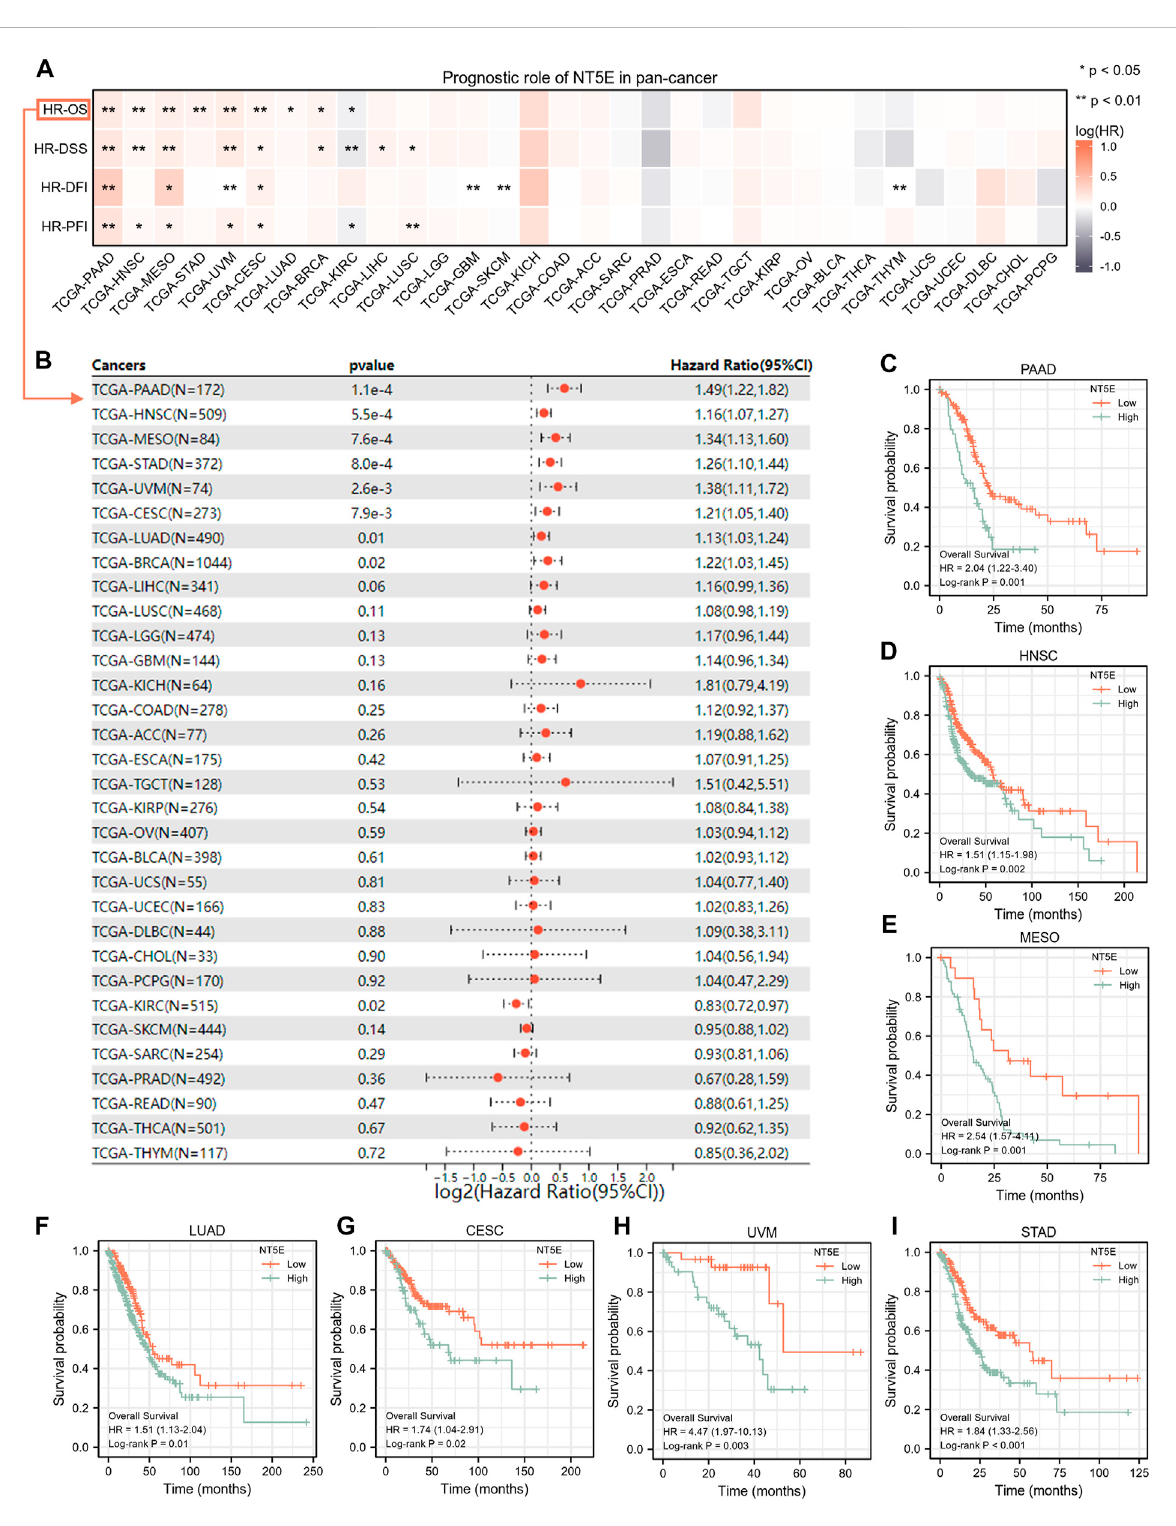
FIGURE 2 (A) the relationship between expression level of NT5E and overall survival (OS), disease-speci fi c survival (DSS), disease-free interval (DFI) and progression-freeinterval(PFI)throughtheunivariateCoxregressionandKaplan-Meiermodels.RedrepresentsthatNT5Eisariskfactor,andgrayindicatesa protectivefactorrelatedtoprognosis.Only p values < 0.05wereshown. (B) TheforestplotshowedtheprognosticvalueofNT5Eincancersusingunivariate Coxregressionmethod. (C – I) Kaplan-MeieroverallsurvivalcurvesofNT5EinPAAD(HR=2.04;95%CI=1.22 – 3.40; p =0.001) (C) , HNSC (HR=1.51; CI=1.51 – 1.98; p =0.002) (D) ,MESO(HR=2.54;CI=1.57 – 4.11; p =0.001) (E) ,LUAD(HR=1.51;CI=1.13 – 2.04; p =0.01) (F) ,CESC(HR=1.74;CI=1.04 – 2.91; p = 0.02) (G) , UVM (HR = 4.47; CI = 1.97 – 10.13; p = 0.003) (H) , and STAD (HR = 1.84; CI= 1.32 – 2.56; p < 0.001) (I) (* p < 0.05; ** p <